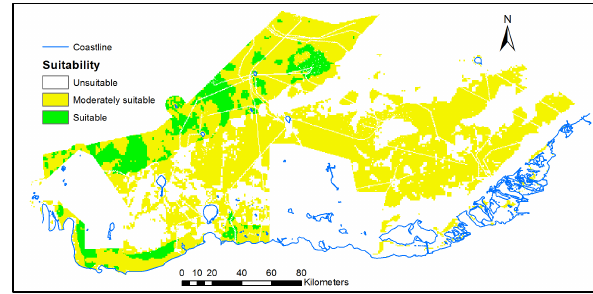
Figure 9: Suitability